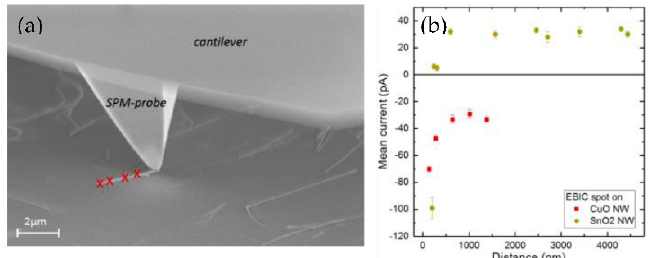
Figure 3. ( a ) SPM-probe placed on CuO NW, red crosses are exemplary positions of electron beam focus points on the CuO NW; ( b ) EBIC measurement on SnO 2 NWs (dark yellow circles) and CuO NWs (red squares). Distances measured along the direct path between electron beam focus point and